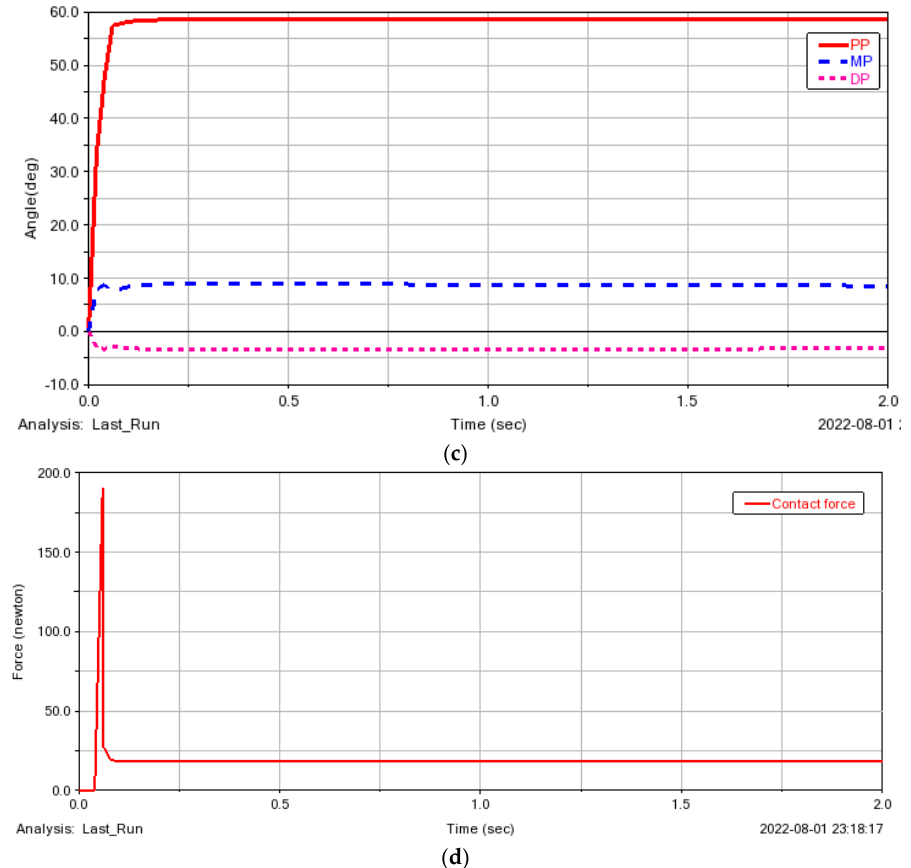
Figure 10. Changes in parameters in the process of grasping a sphere. ( a ) Grasping the ball: phalanxes rotation angle. ( b ) Grasping the ball: contact force. ( c ) Pinching the ball: phalanxes rotation angle; ( d ) Pinching the ball: contact force.